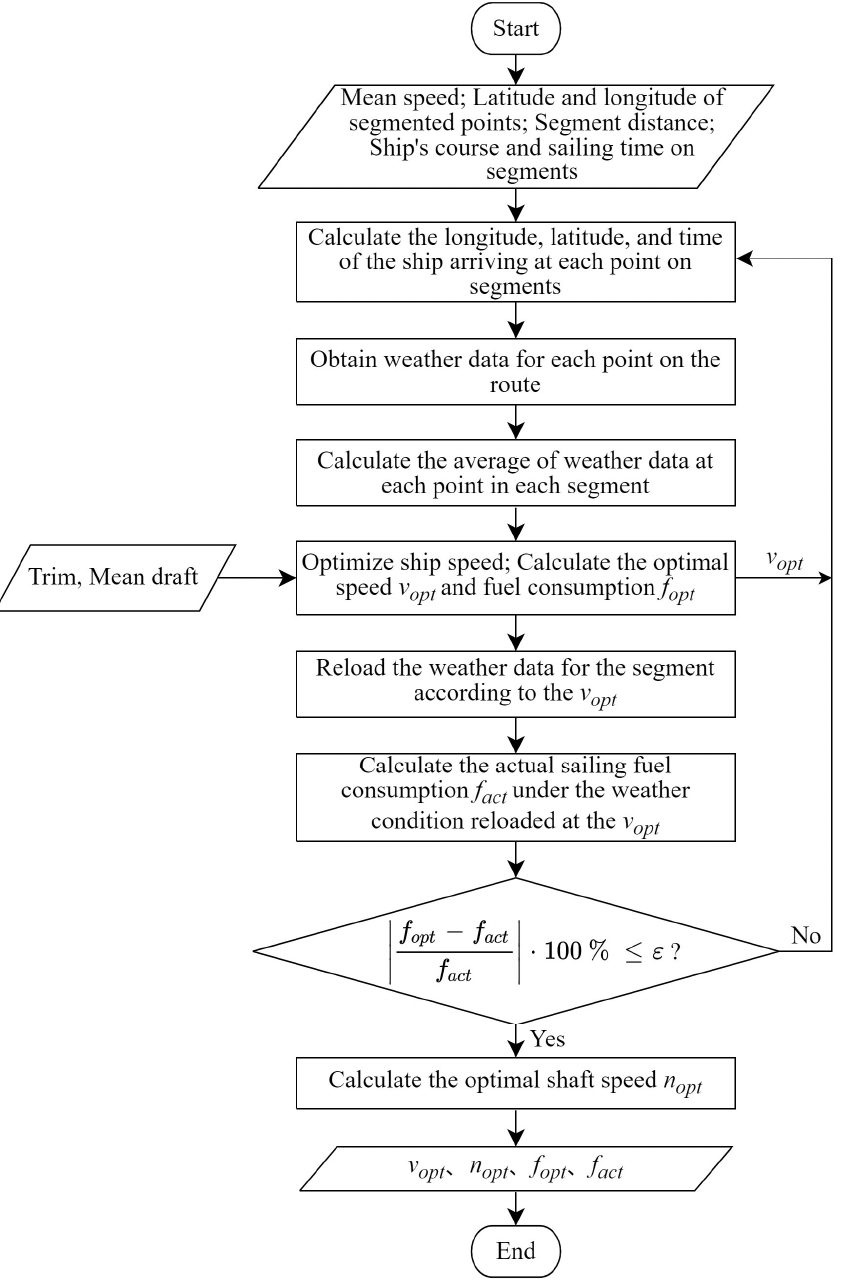
Figure 5. Flow chart of weather loading-speed optimization iterative algorithm.